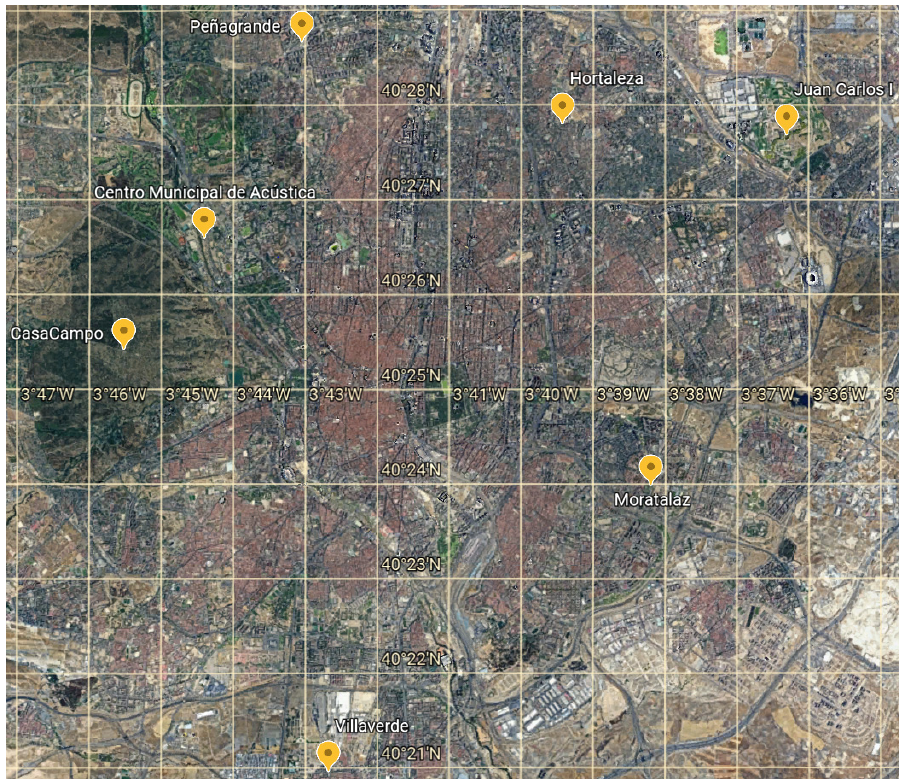
Figure 12. Location of the ground-based stations in the Community of Madrid used in the research.